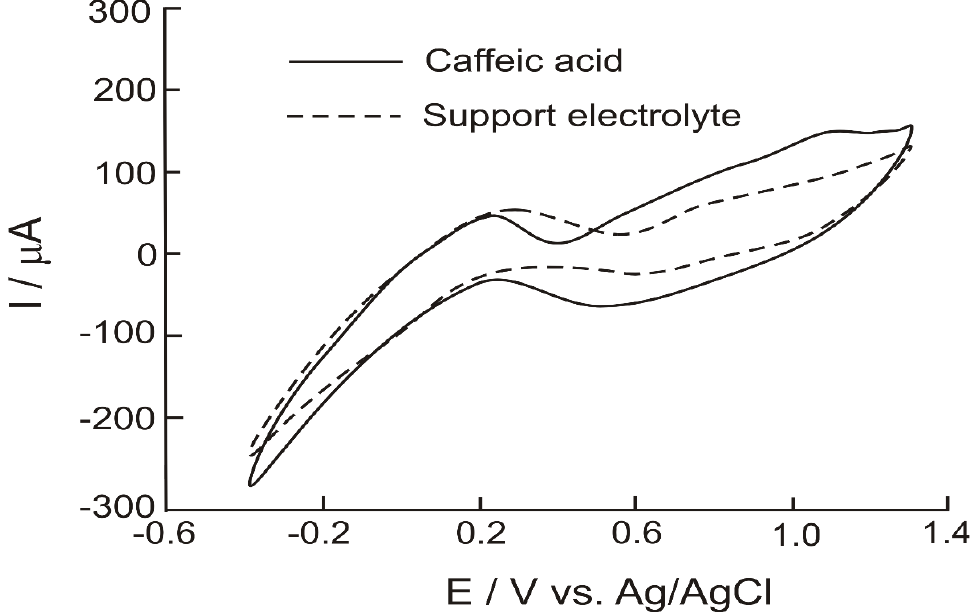
Figure 3. Cyclic voltammogram of SPCE/PB/HRP biosensor immersed in electrolyte support solution (10 − 2 M PBS pH 7–10 − 2 M hydrogen peroxide), (dashed line); cyclic voltammogram of SPCE/PB/HRP biosensor immersed in 30 μ M caffeic acid solution in electrolyte support solution (solid line).